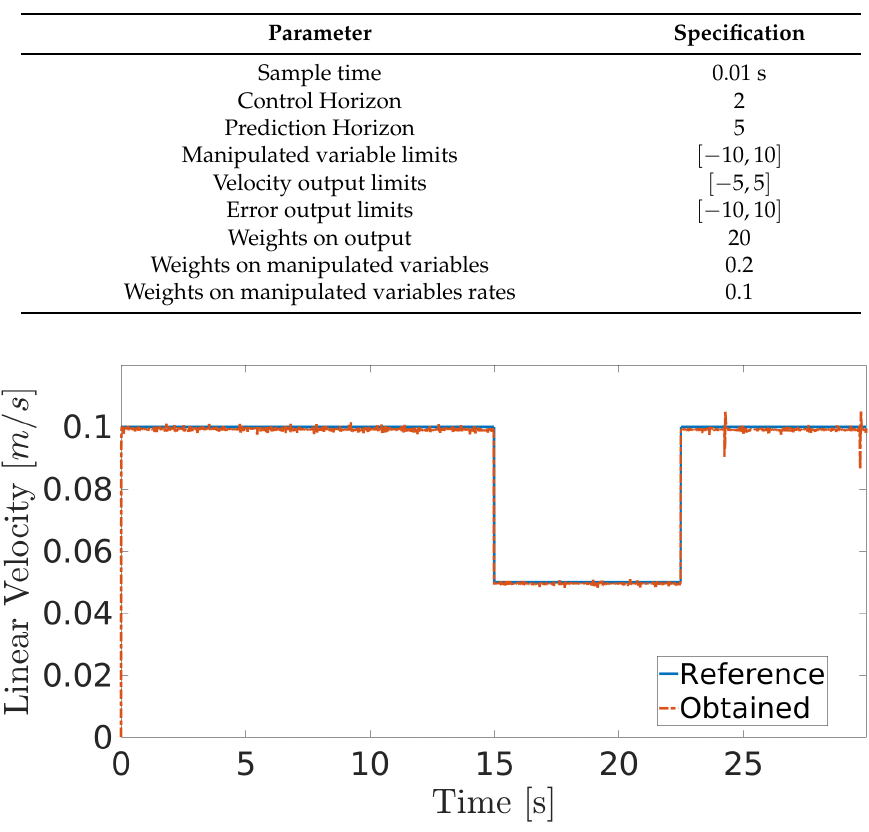
Table 3. Tuning parameters of MPC.